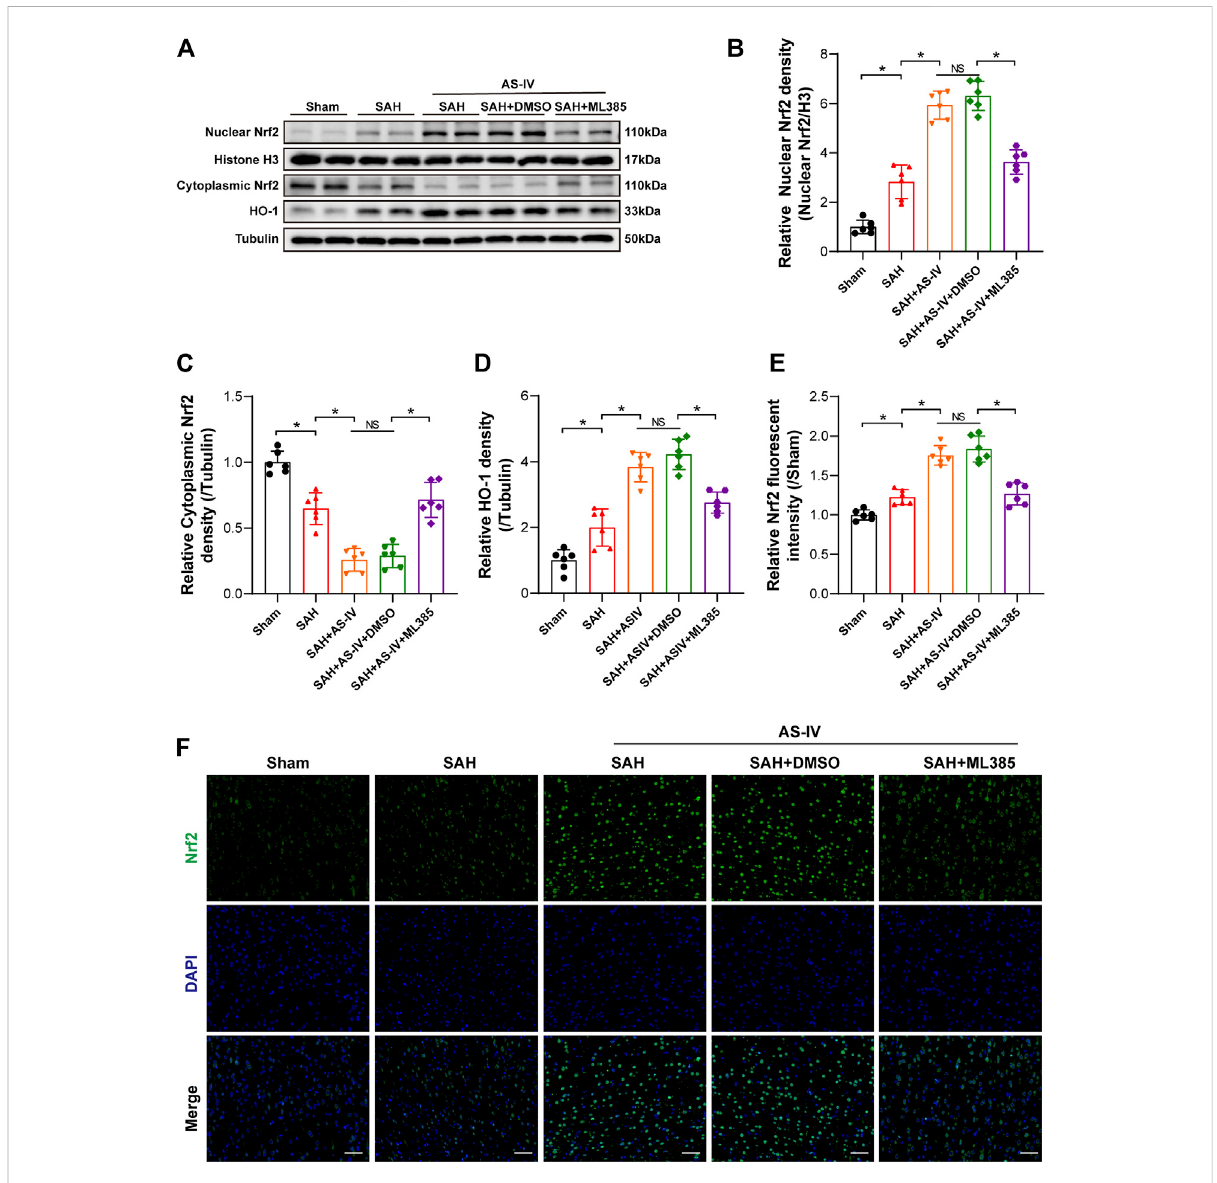
FIGURE 4 AS-IV treatment enhances Nrf2/HO-1 signaling pathway at 24 h post-SAH in rats. (A) Representative Western blotting images of Nuclear Nrf2, Cytoplasmic Nrf2, and HO-1. (B – D) Quanti fi cation of Nuclear Nrf2, Cytoplasmic Nrf2, and HO-1 (n = 6). (E) Quanti fi cation